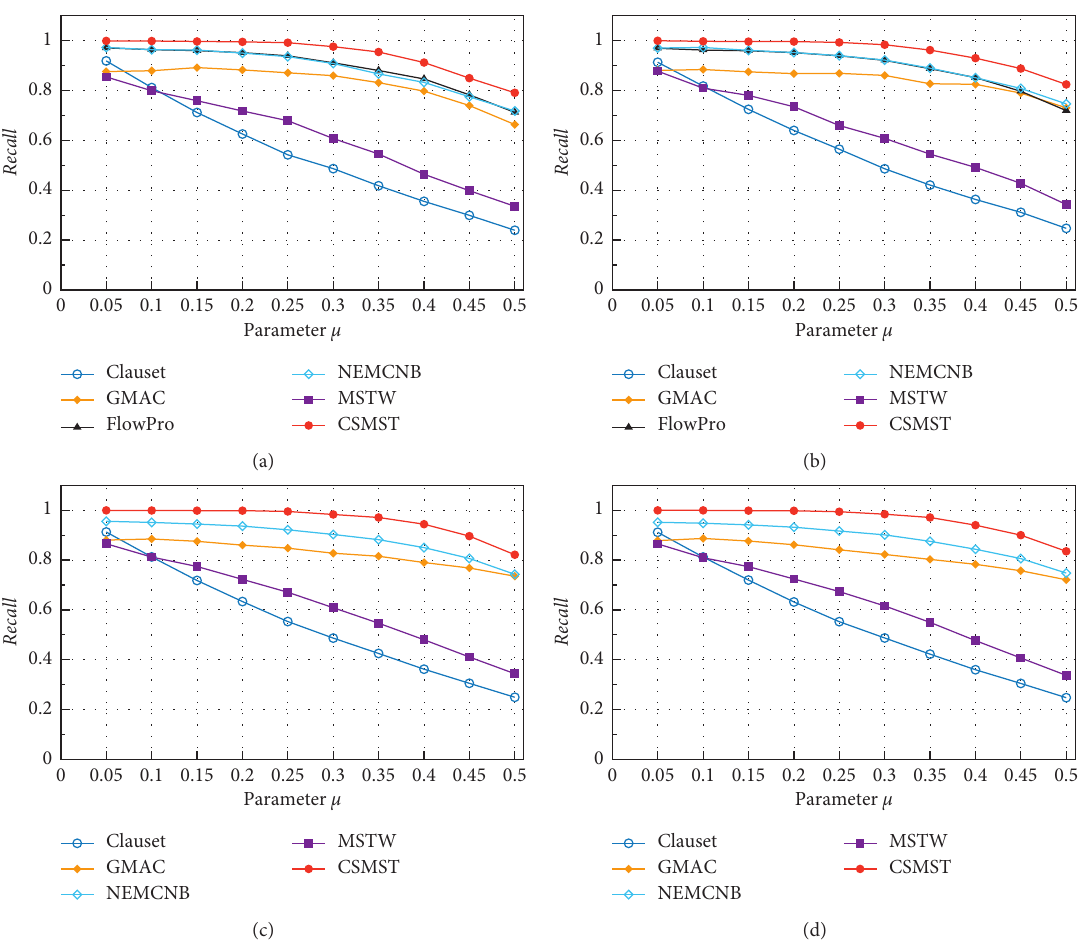
Figure 4: Comparison results on LFR networks with community search baselines. (a) Comparison results on LFR5K. (b) Comparison results on LFR10K. (c) Comparison results on LFR30K. (d) Comparison results on